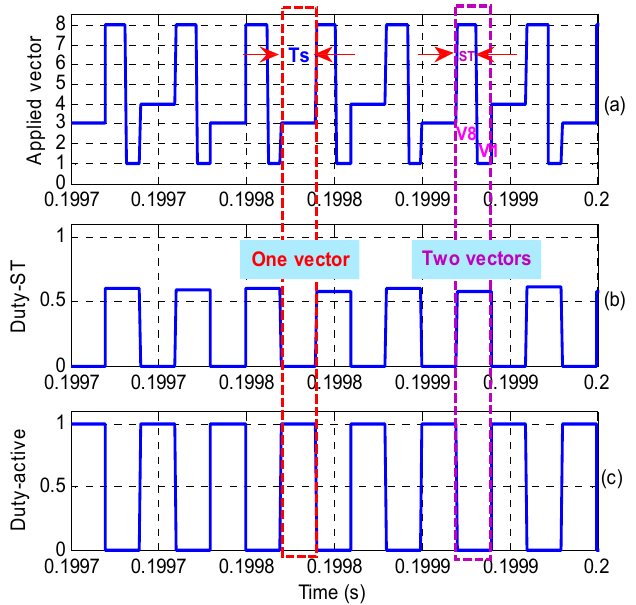
Figure 15. Steady-state performance of qZSI with modulated MPC with 22 vectors transitions during 0.0003 s in boosting mode at 20 μs : ( a ) optimal voltage vector in boosting mode, ( b ) duty in the shoot-through state, and ( c ) duty in the active state.